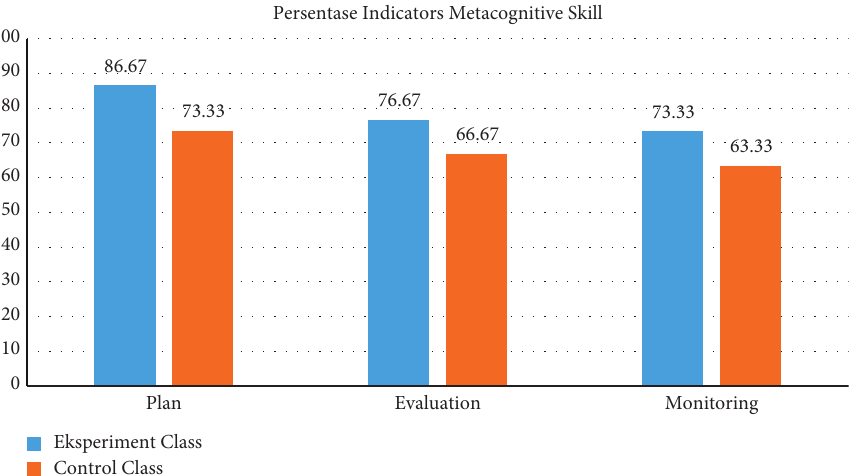
Figure 3: Percentages of metacognitive skill indicators.